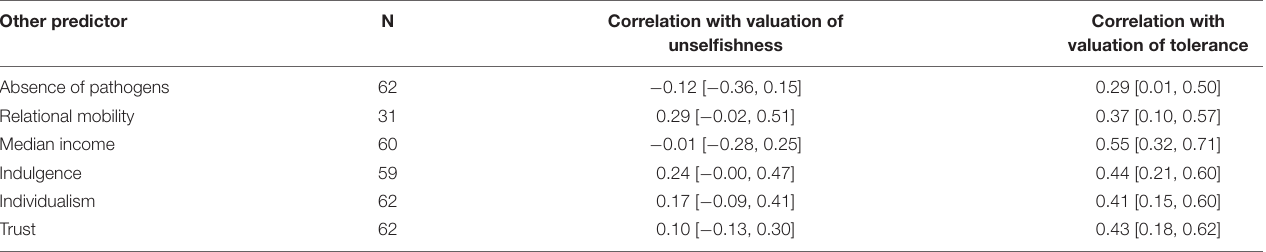
TABLE 3 | Pearson correlations between valuations of personal qualities and other predictors of cooperation. Other predictor N